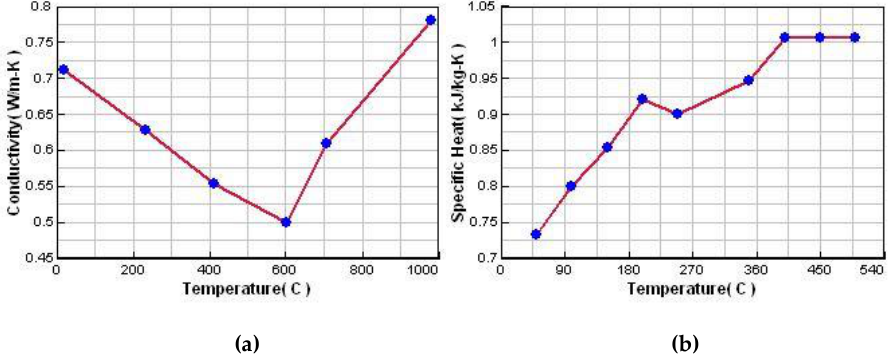
Figure 5. Thermal physical and mechanical properties of A356 alloy: (a) density; (b) heat conductivity; (c) enthalpy; (d) elastic modulus; (e) P oisson’s ratio and (f) thermal expansion coefficient.